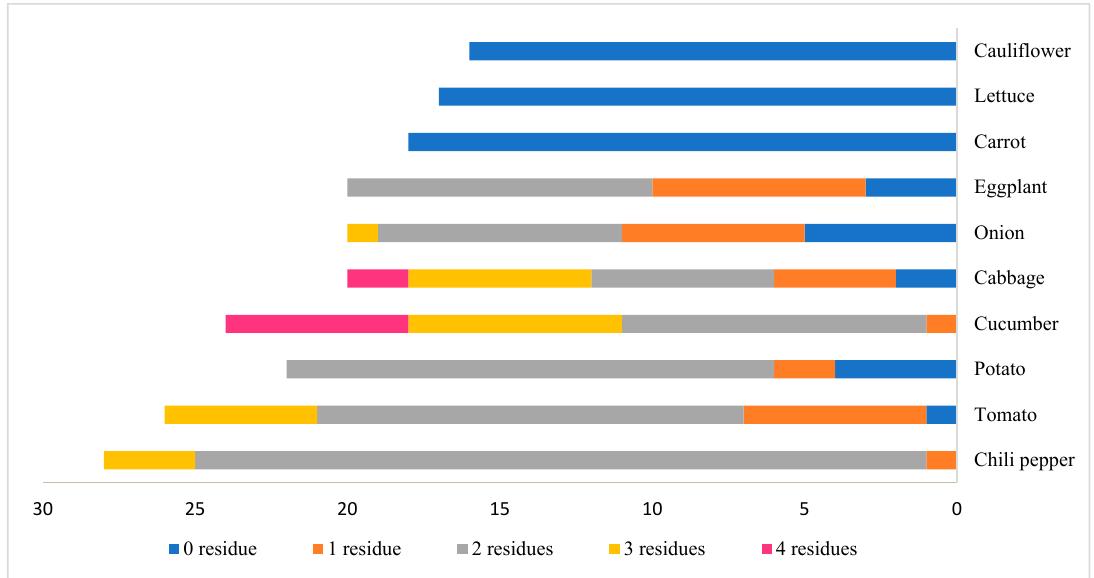
Figure 3. The occurrence of multiple residues in different vegetables.